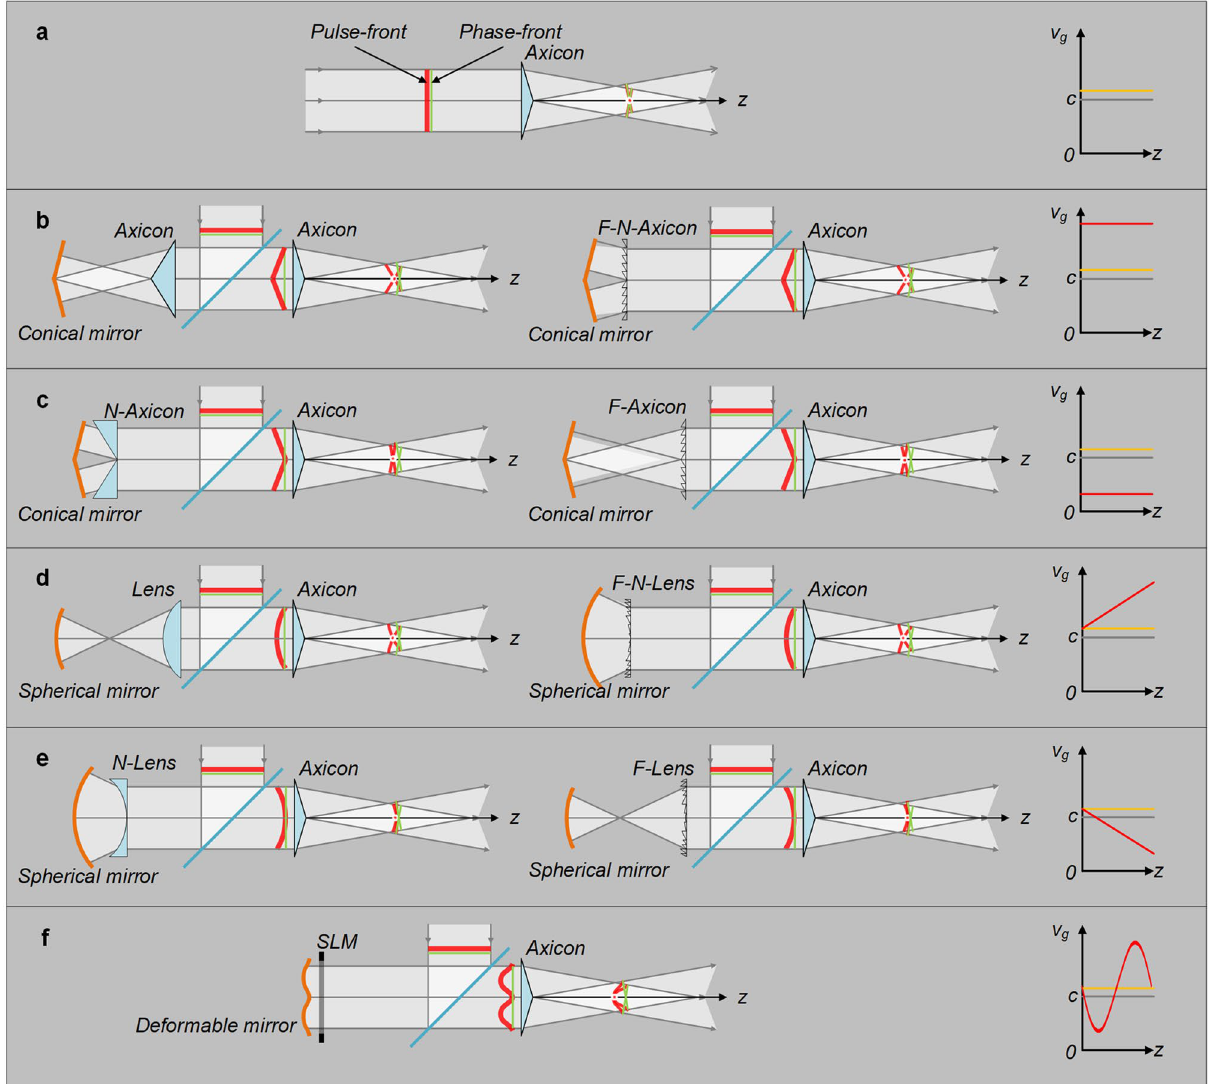
Figure 1. Axicon generated propagation-invariant optical wave-packets for different pulse-front deformations. ( a ) Without any pulse-front deformation, propagation-invariant optical wave-packet has a constant slightly- superluminal group-velocity (yellow curve), and light speed c in vacuum is given for reference (gray curve); ( b ) setups and generated concave-conical pulse-front deformation, propagation-invariant optical wave- packet has a superluminal group-velocity (red curve); ( c ) setups and generated convex-conical pulse-front deformation, propagation-invariant optical wave-packet has a subluminal group-velocity (red curve); ( d ) setups and generated concave-spherical pulse-front deformation, propagation-invariant optical wave-packet has an accelerating group-velocity (red curve); ( e ) setups and generated convex-spherical pulse-front deformation, propagation-invariant optical wave-packet has a decelerating group-velocity (red curve); and ( f ) setup and generated axisymmetric complex pulse-front deformation, propagation-invariant optical wave-packet has a variable group-velocity. F-Axicon Fresnel axicon, F-N-Axicon Fresnel negative axicon, N-Axicon negative axicon, F-Lens Fresnel lens, F-N-Lens Fresnel negative lens, N-Lens negative lens, SLM spatial light modulator. Figure generated by Microsoft® Visio® 2013 50